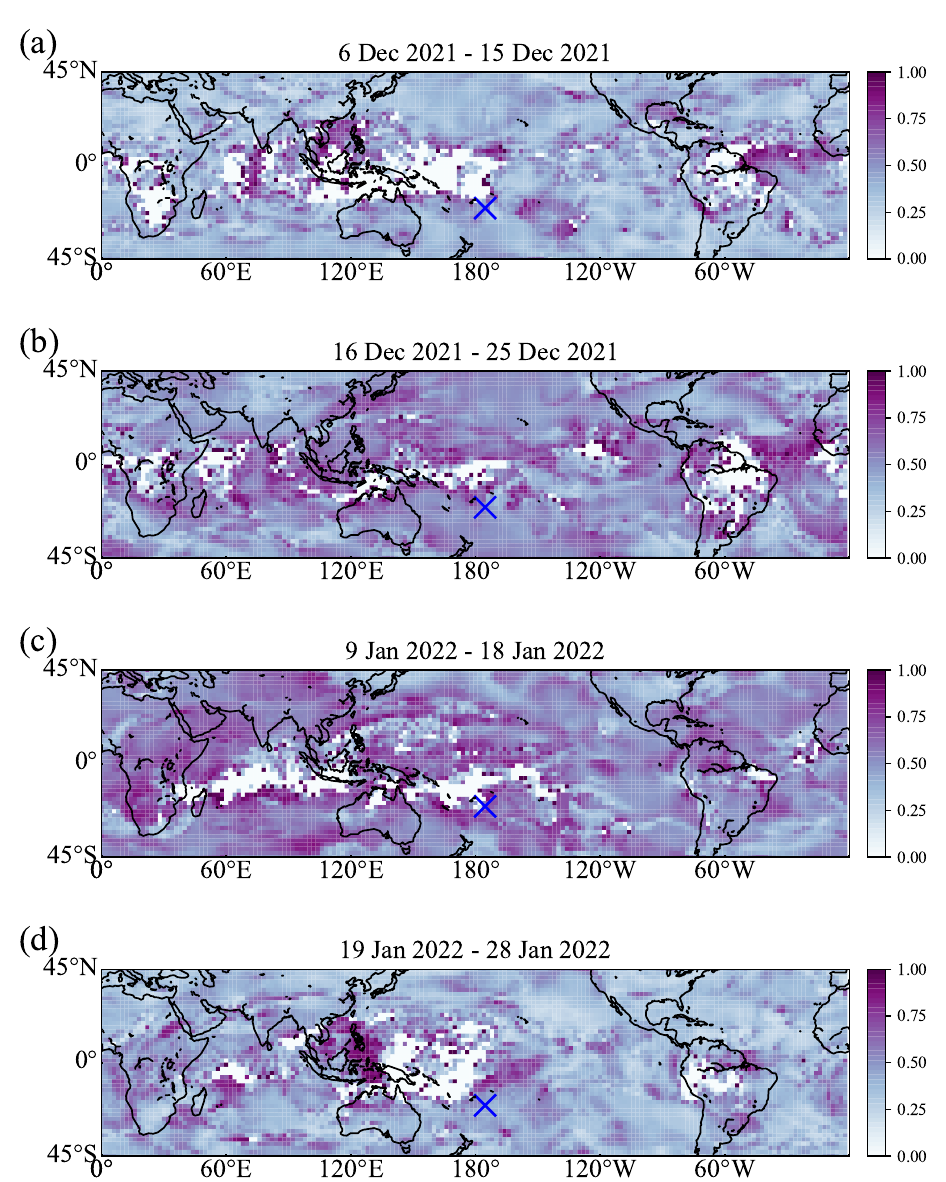
Figure 6. Network local clustering coefficient fields over the period ( a ) before eruption, ( b ) the first dominant eruption, ( c ) the second dominant eruption, and ( d ) after the eruption of the HTHH. The corresponding periods are marked at the top of each